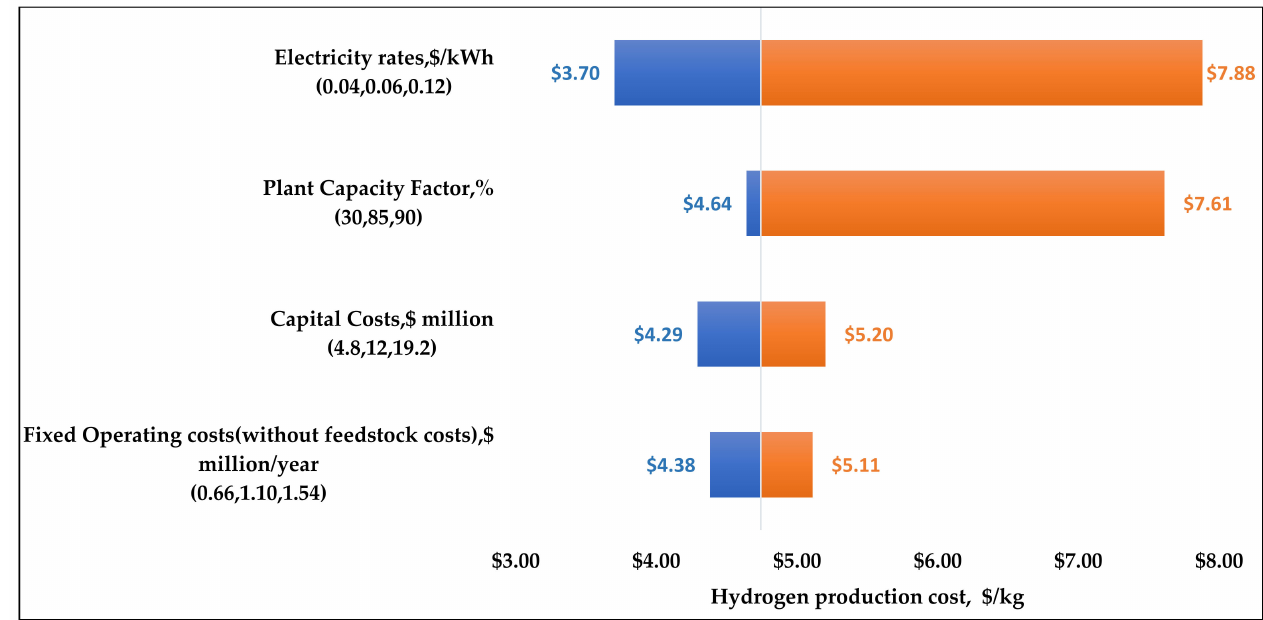
Figure 10. Range of hydrogen production costs for a 5 tpd forecourt electrolysis